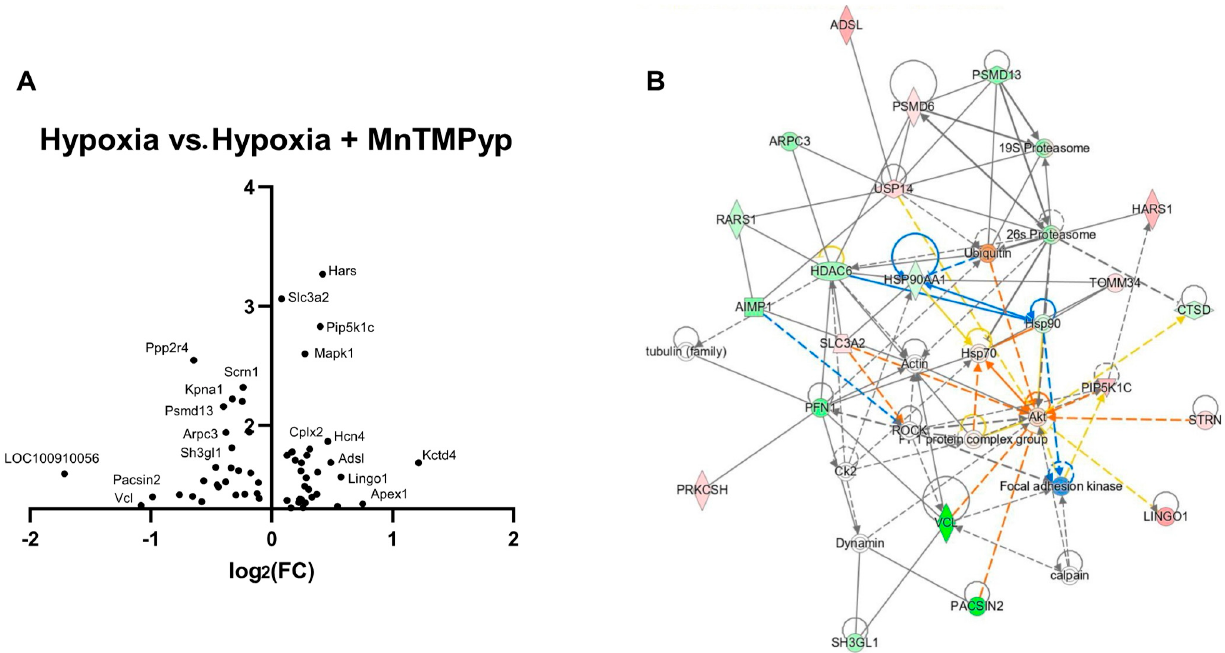
Figure 7. Application of MnTMPyP downregulates synaptogenesis signalling following hypoxic insult. ( A ) A volcano plot shows major upregulation of potassium-channel-associated Kctd4 and downregulation of LOC100910056, also knows as Bltp3b, involved in endosomal vesicle transport. ( B ) The most enriched network ( p = 1.00 × 10 − 52 ) is centred around actin, implicated in maintaining neuronal structure and integrity, in addition to numerous heat shock proteins (HSPAA1, HSP70; downregulated, HSP90; upregulated) responsible for cellular stress response. Table 4. Ingenuity pathway analysis of CA1 slices treated with hypoxia + MnTMPyP, compared to vehicle-treated hypoxia. Ingenuity-generated associated canonical pathways, ranked by − log ( p - value), show the top canonical pathways concern themes such as apoptosis regulation (Sirtuin, p = 1.2 × 10 − 8 ), cell stress regulation (BAG2, p = 3.31 × 10 − 5 ) and mitochondria ( p = 9.77 × 10 − 5 ), in addition to actin ( p = 1.82 × 10 − 4 ).